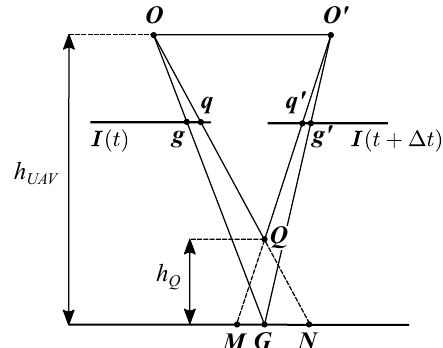
Figure 3. The projective planes of I ( t ) and I ( t + ∆ t ) taken at height h UAV above the ground with the centre of projections at O and O’ , respectively, observing a point at Q at the height h Q above the